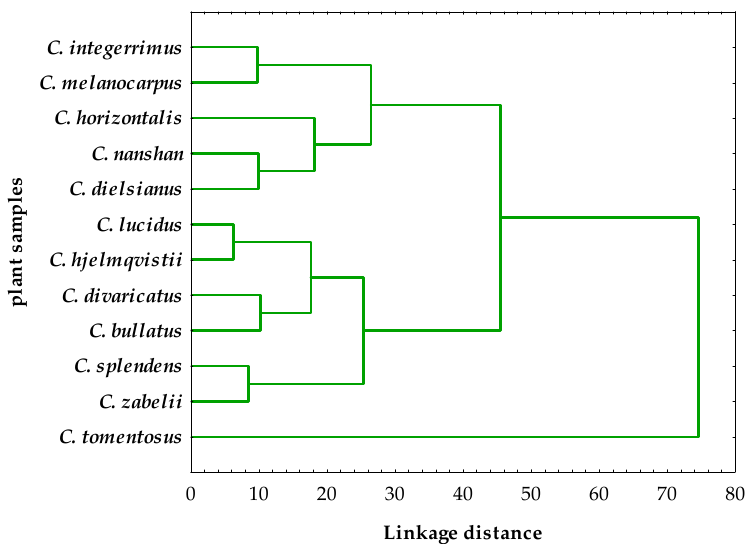
Figure 4. Hierarchical cluster analysis with all variables obtained for the Cotoneaster leaves using the complete linkage method and Euclidean squared distance.